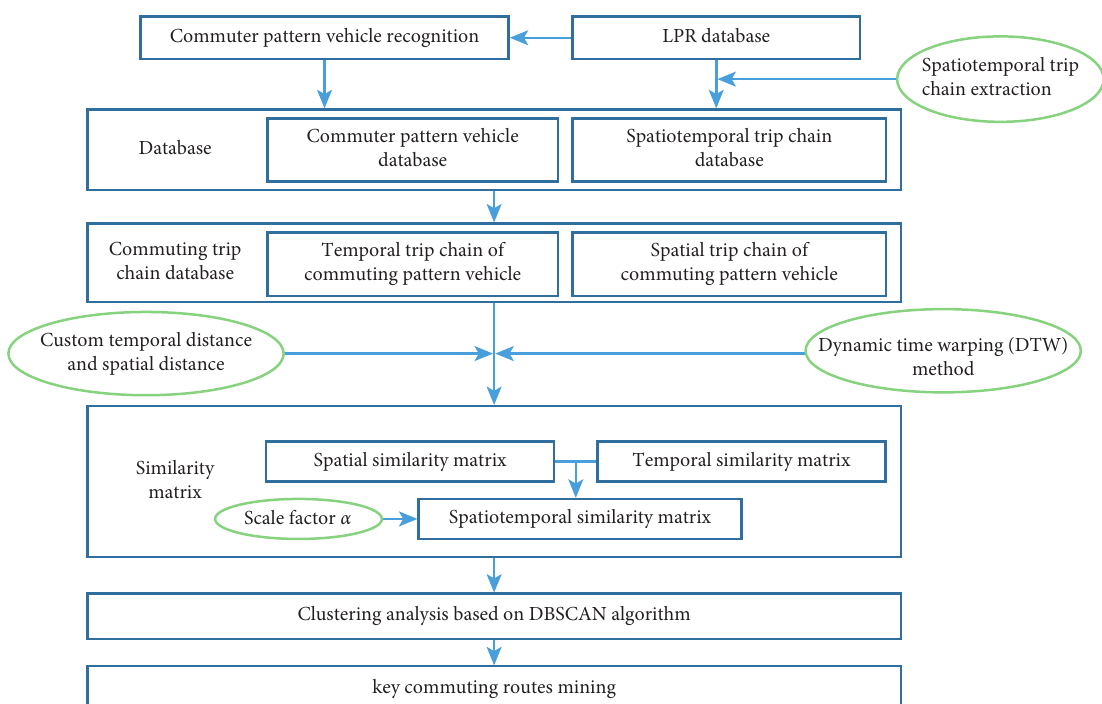
Figure 5: The framework of key commuting route mining algorithm based on LPR